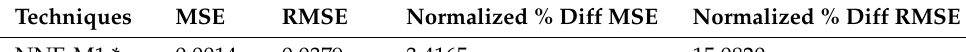
Table 4. Comparison of the best single model and ensemble for TDS.